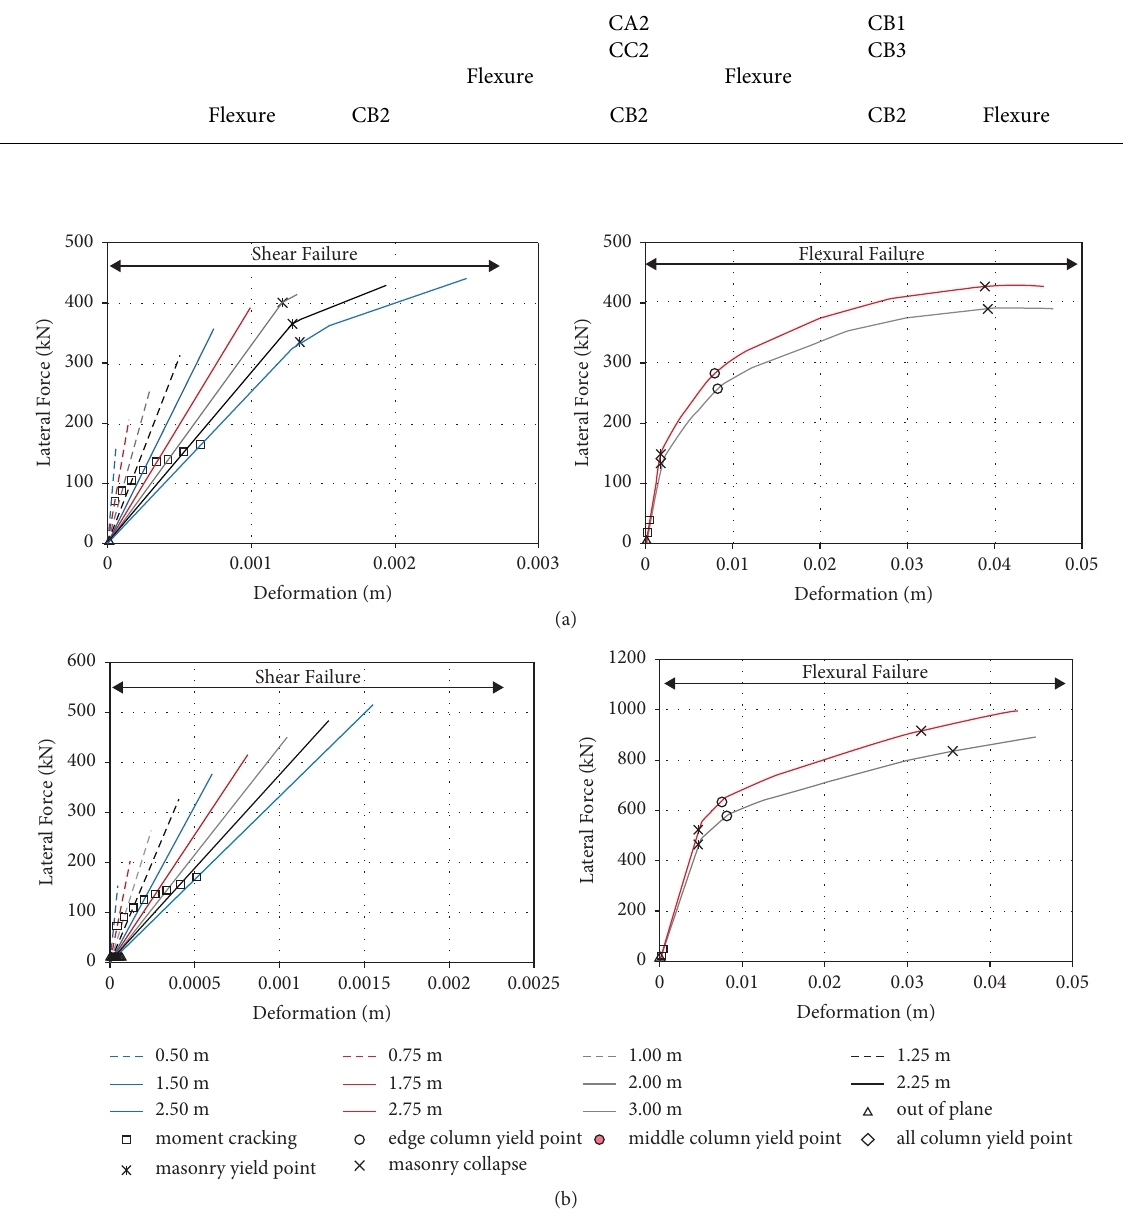
Figure 10: Relationship of lateral resistance and roof deformation of hollow brick walls (HB) and clay brick walls (CB) for 90 ° fow directions. (a) HB-90 ° . (b) CB-90 ° .